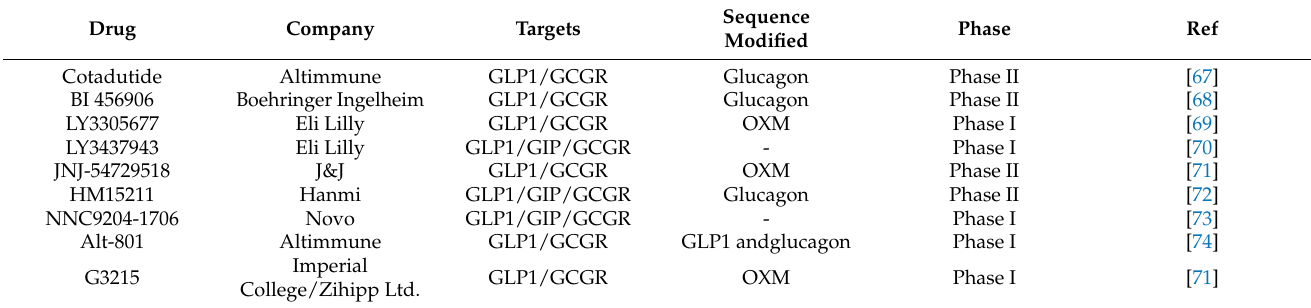
Table 3. Current antidiabesity multitarget-drugs in